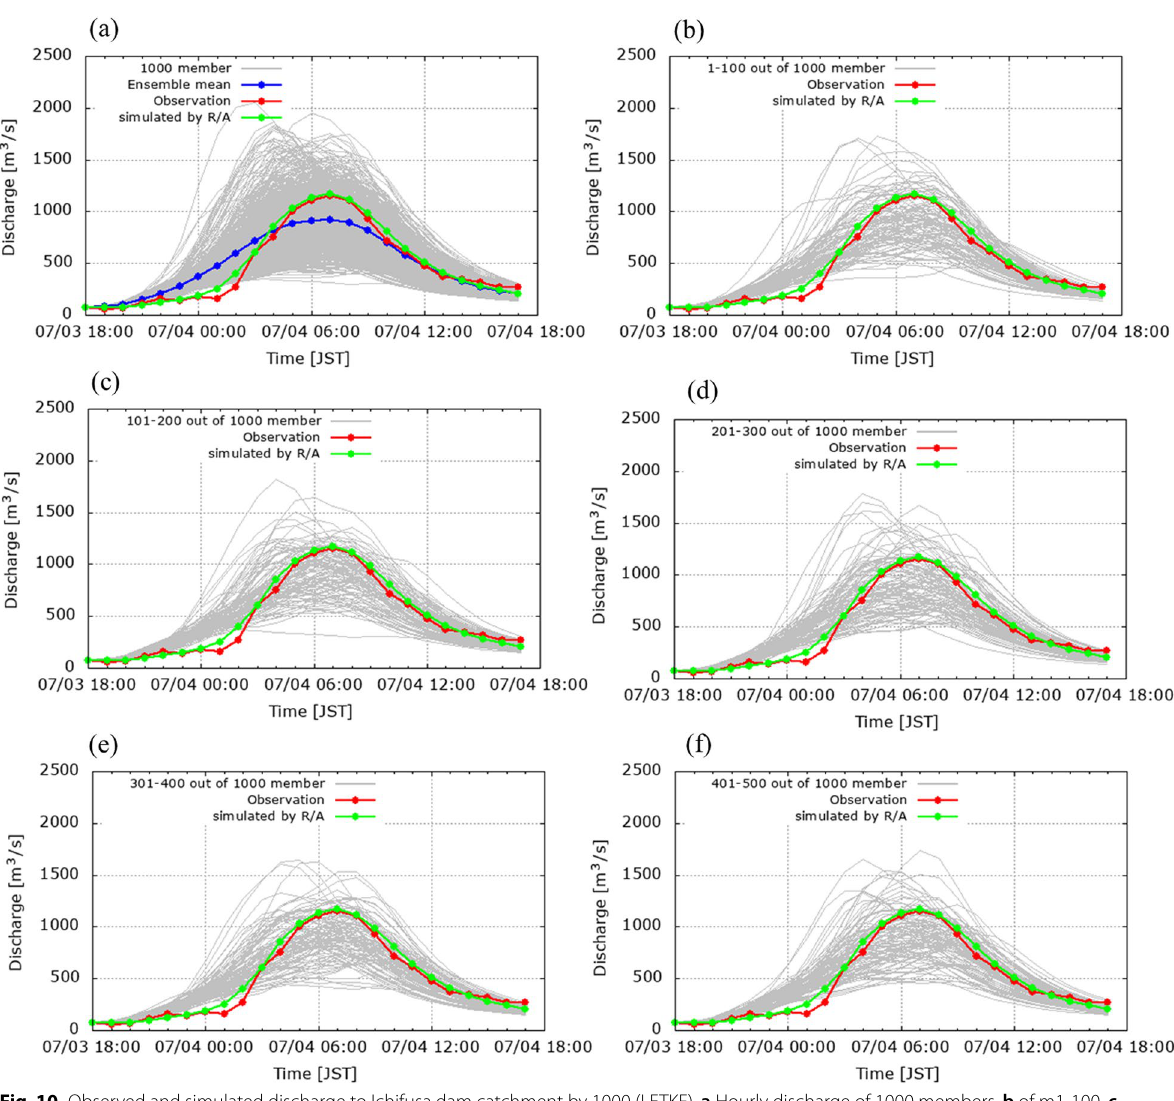
Fig. 10 Observed and simulated discharge to Ichifusa dam catchment by 1000 (LETKF). a Hourly discharge of 1000 members, b of m1-100,